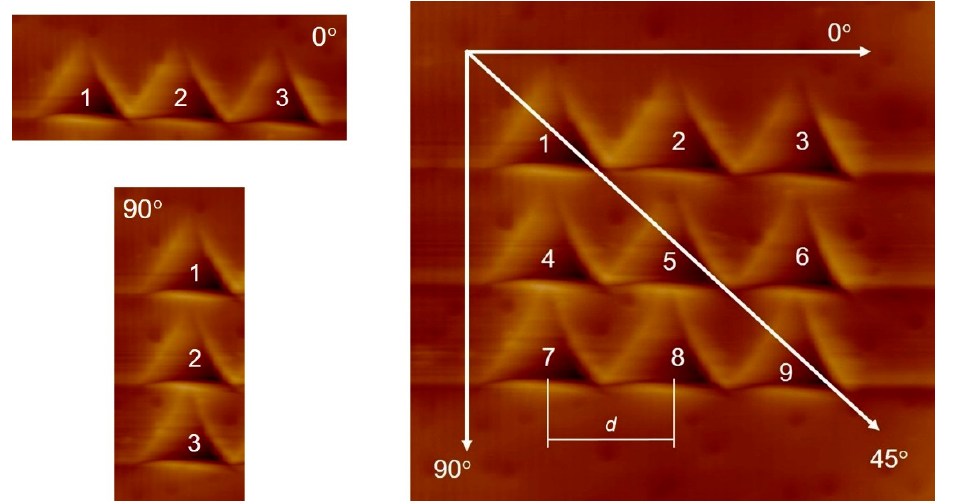
Figure 1. Schematics of indentation orientation and indent position in a single row (orientation 0 ° ), column (orientation 90 ° ), and 3 × 3 matrix. d —spacing between indents.